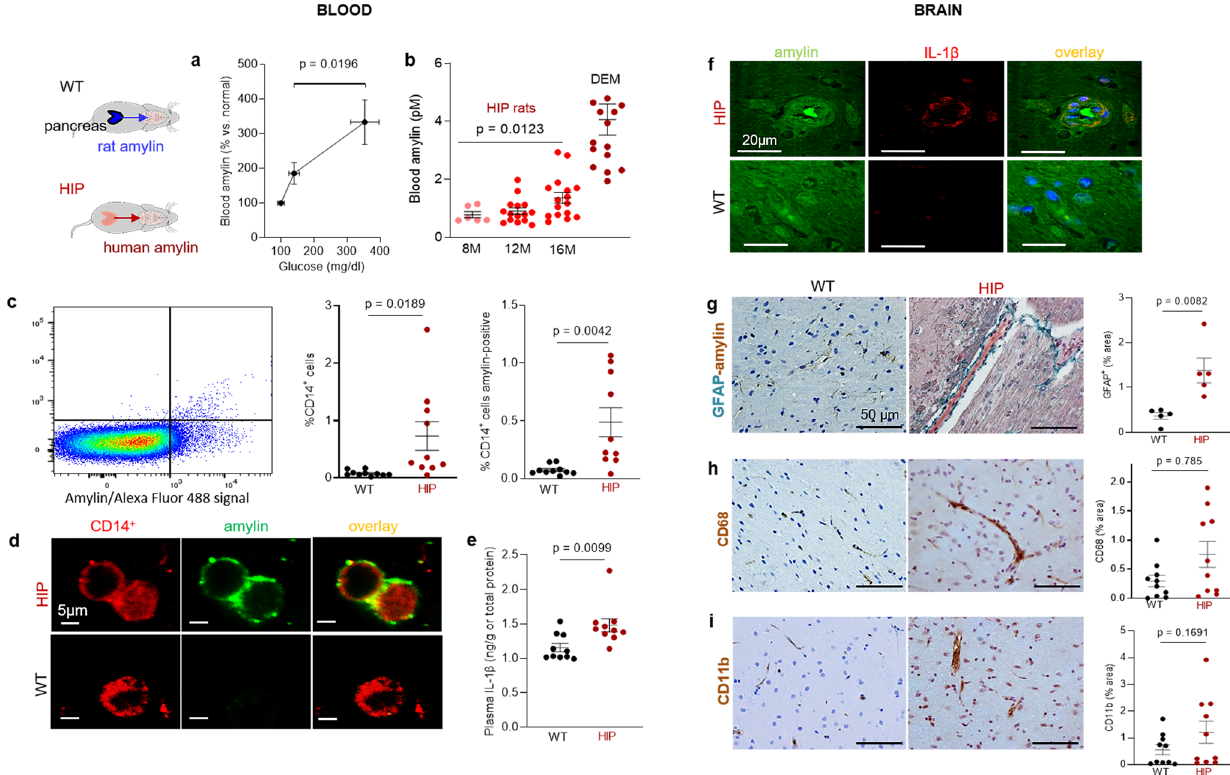
Fig. 2 Systemic and cerebrovascular in fl ammation in rats with pancreatic expression of amyloid-forming human amylin (HIP rats). a Cross-sectional blood amylin and glucose concentrations in HIP rats age 6 – 8 months ( n = 6), age 10 – 12 months ( n = 13), and age 15 – 16 months ( n = 12). b Blood amylin concentrations in humans with dementia (DEM) vs. HIP rats; same rats as in ( n = 16) ( a ). c Flow cytometry sorting of circulating CD14 + monocytes positive for amylin in blood from same rats as in ( b ) ( n = 10 males/group). d Confocal microscopic images of circulating monocytes stained for CD14 + (red) and amylin (green) in blood from the same rats as in ( b ) ( n = 5 blood samples/group). e Interleukin (IL)-1 β ELISA in plasma from HIP vs WT rats similar to groups in ( b ) ( n = 10 males/group). f Confocal microscopic images showing IL-1 β and amylin deposits in brain blood vessels in rats studied in ( b ) ( n = 3 males/group). g IHC analysis of brain sections from HIP and WT rats from the same groups as in ( c ) showing vascular deposits of amylin (brown) and astroglial reactions (green stains for glial fi brillar acidic protein; GFAP) ( n = 5 males/group). IHC analysis of phagocytic microglia (CD68) ( h ) and vascular monocyte recruitment (CD11b) ( i ) in brain sections from HIP vs WT rats from the same groups as in ( b ) ( n = 10 males/group). Data are means ± SEM; unpaired t -test for all